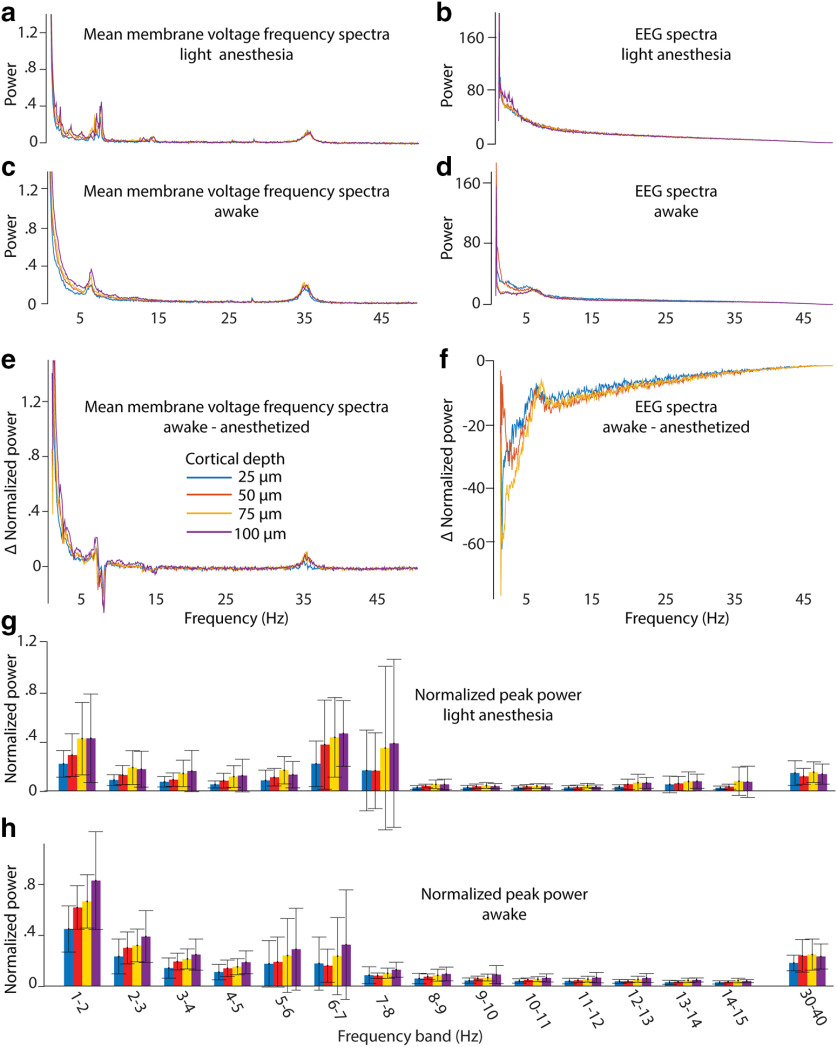
Average frequency spectra. a–f, Average membrane voltage and EEG frequency spectra for awake and lightly anesthetized conditions, separated by cortical depth (210 averages, 7 mice; a–d), and difference between awake and anesthetized spectra (e, f). g, h, Small frequency bands were examined, and the maximum power was plotted for anesthetized (g) and awake (h) spectra. Colors indicate cortical depth; error bars show the SD (7 mice).